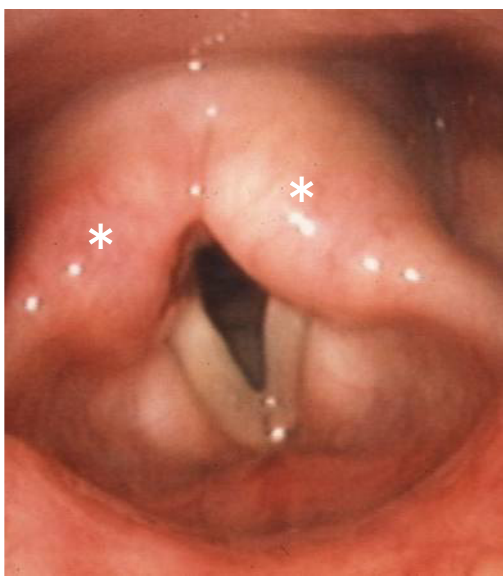
Figure 1 Characteristic laryngeal findings, pallor, and mild swelling of the arytenoid (*) observed in patients with chronic